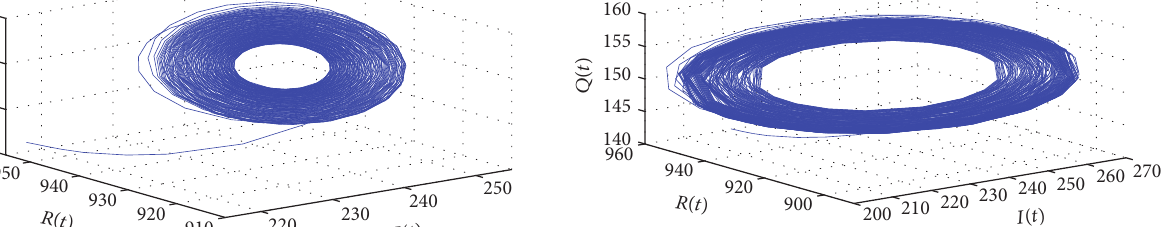
= 3.574 and 𝜏 = 2.25 ∈ (0,𝜏 ) . 1 2 20